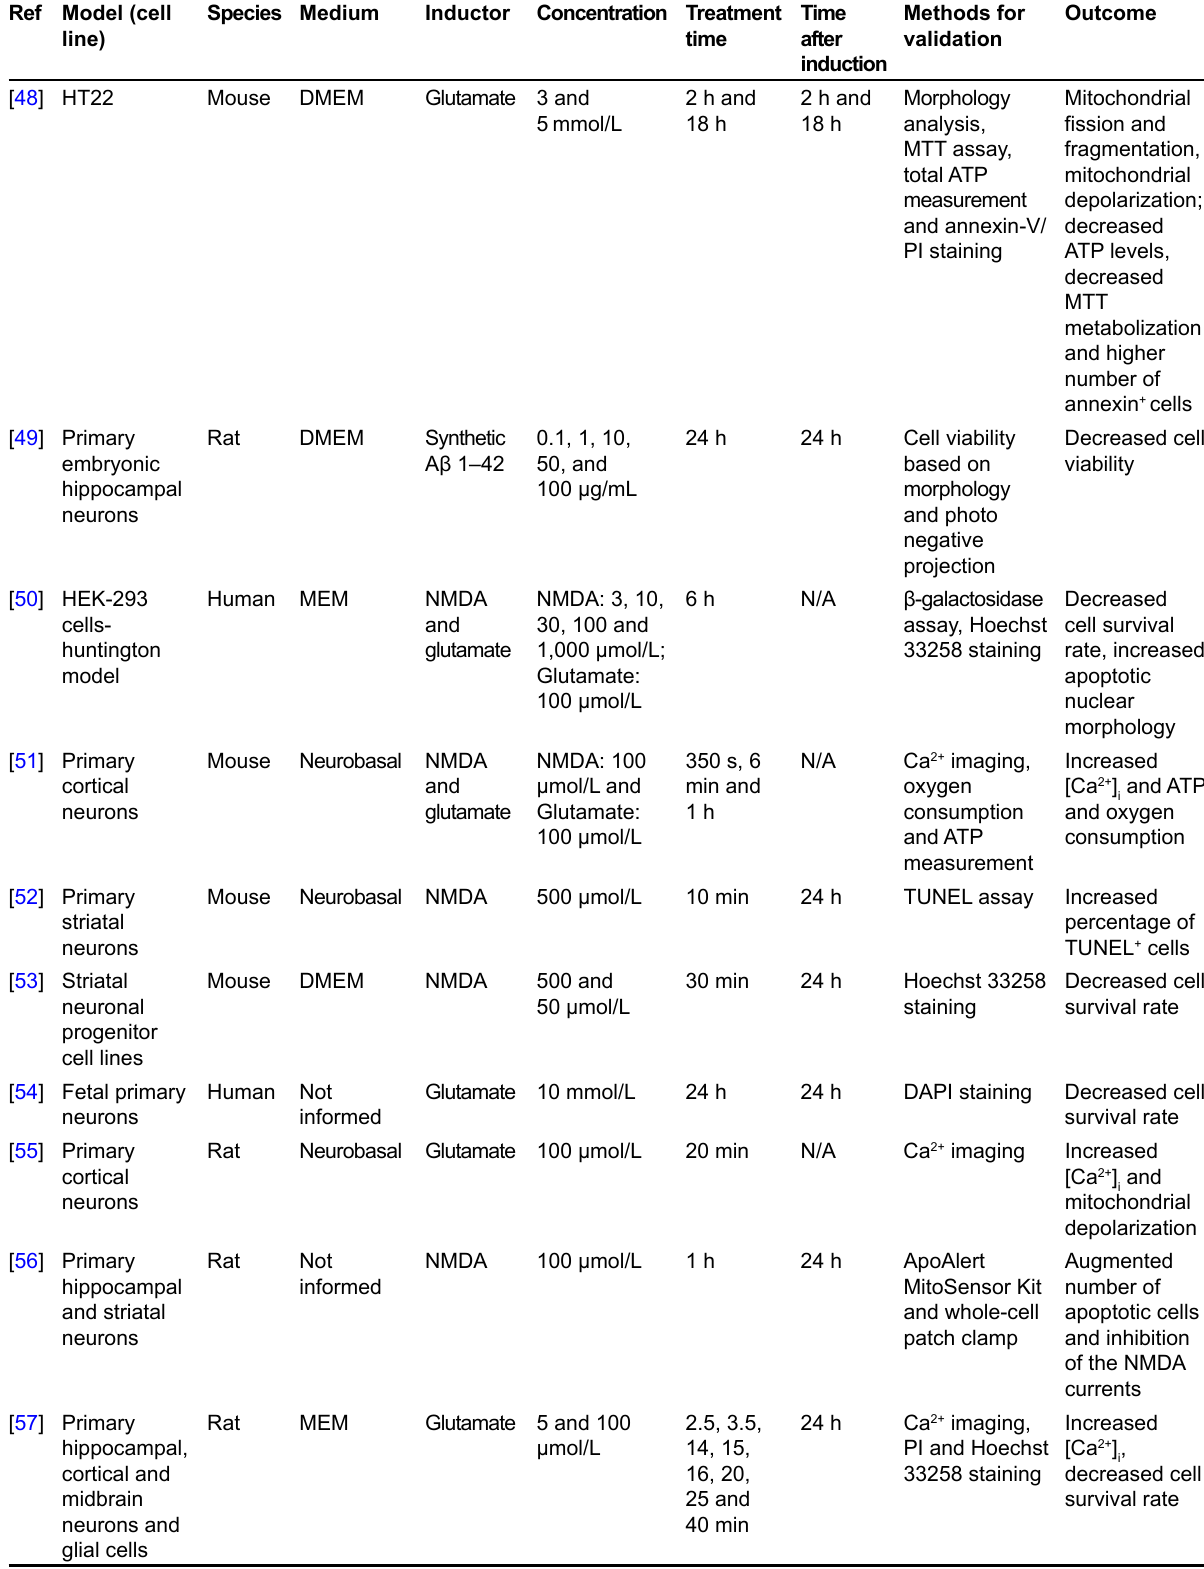
Table 1. Experimental aspects used in published excitotoxicity papers ( continued ) Ref Model